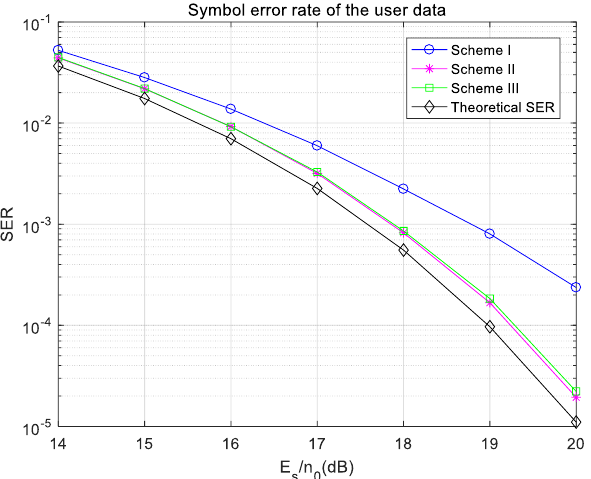
Figure 9. Symbol error rates of the user data under ideal synchronization in the Gaussian channel.